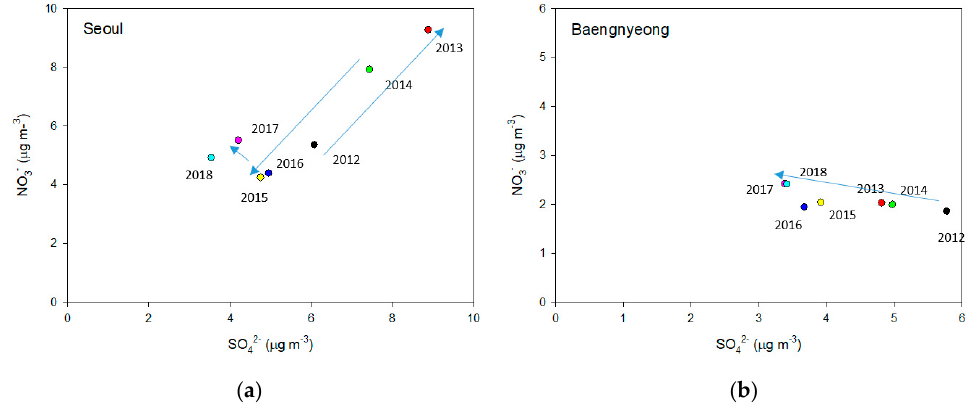
Figure 7. The changes in SO 42– and NO 3– concentrations: ( a ) Seoul; ( b ) Baengnyeong Island. 3.4. SOR and NOR in Seoul and on Baengnyeong Island According to PM2.5 Concentration and RH